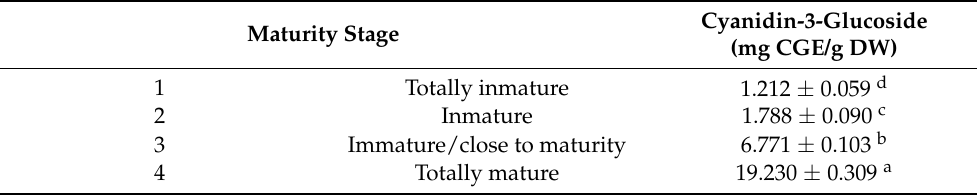
Table 5. HPTLC quantification of cyanidin-3-glucoside in methanolic extracts of Vaccinium stenophyllum Steud. fruits during ripening.